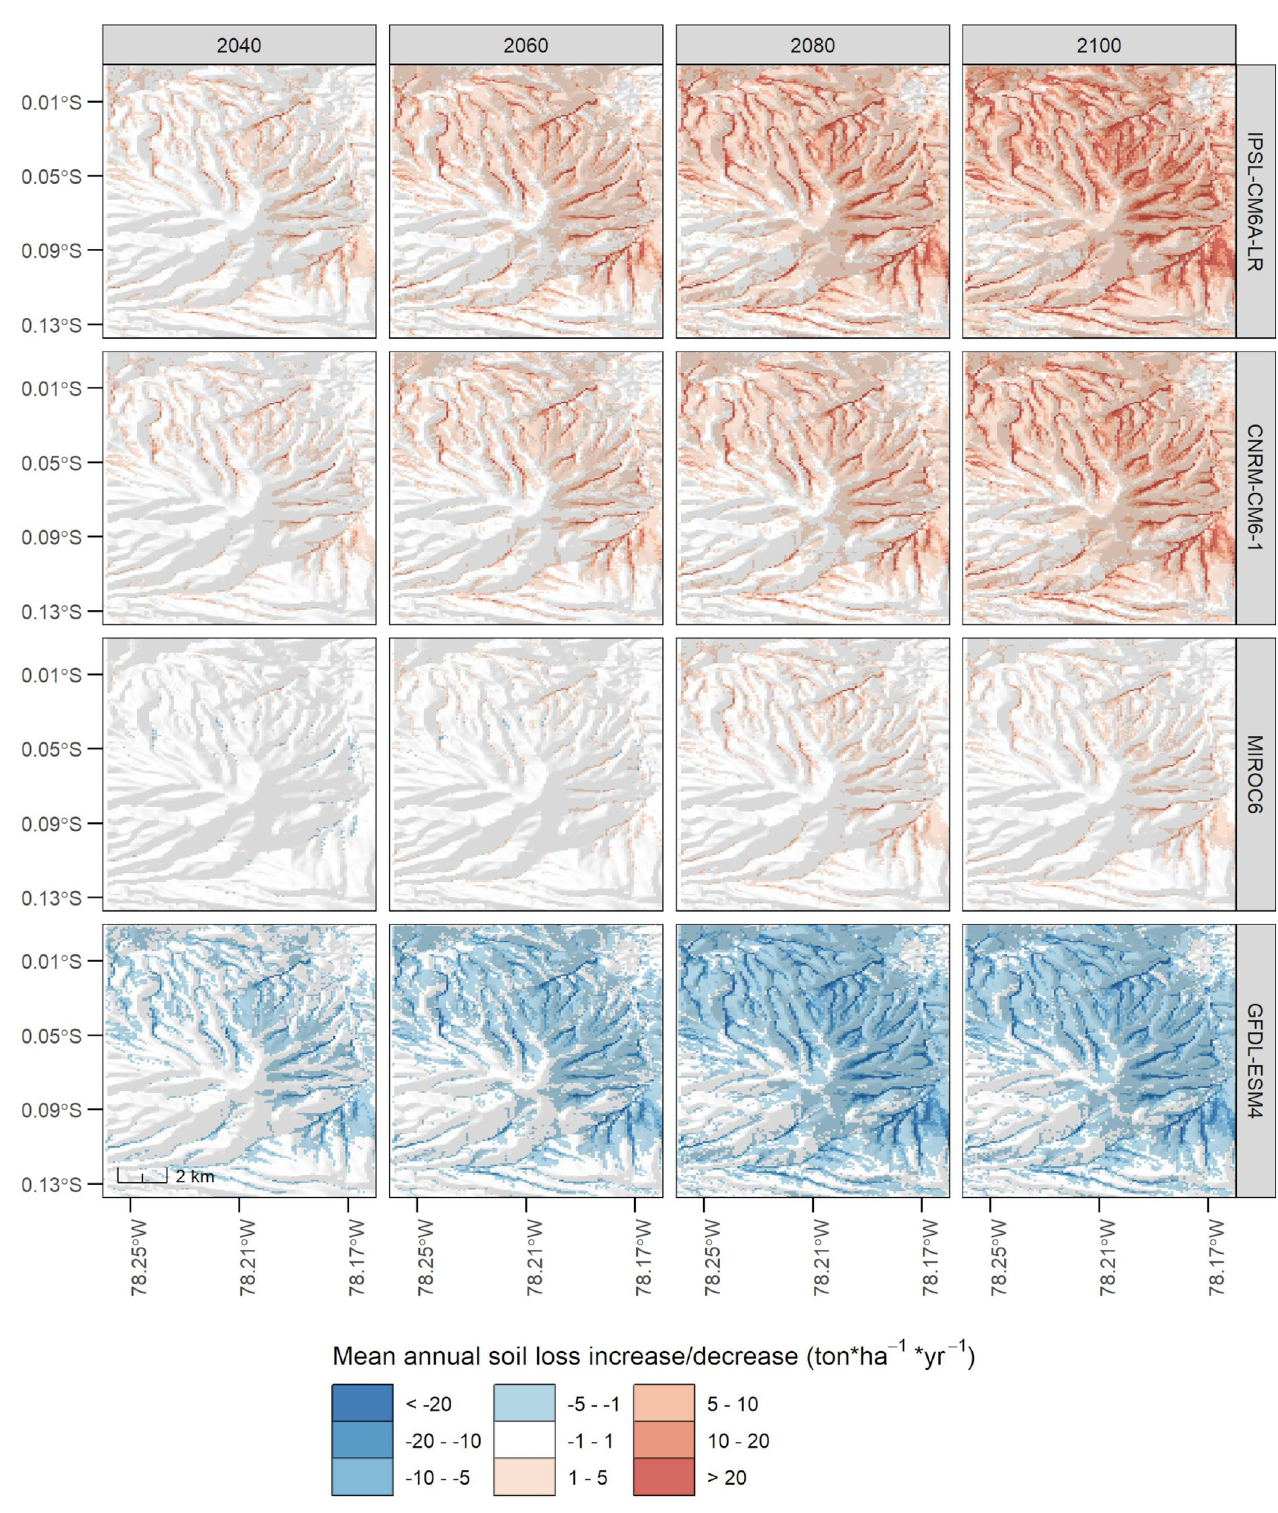
Fig 6. Spatial representation of mean annual soil loss increase/decrease derived with the different modeling centers (rows) and time steps (columns) with the SSP5-8.5.